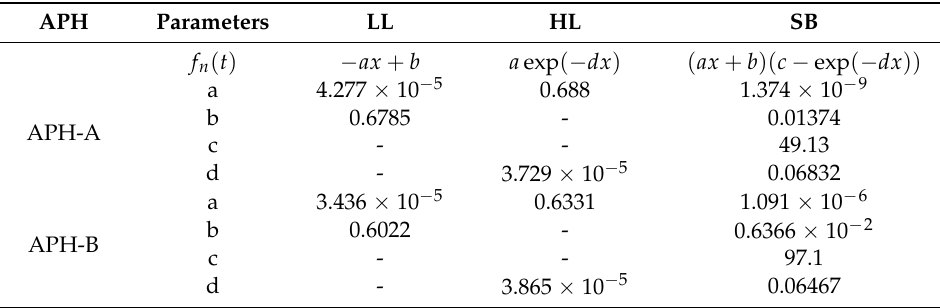
Table 3. Parameters of the functions in Figure 6.